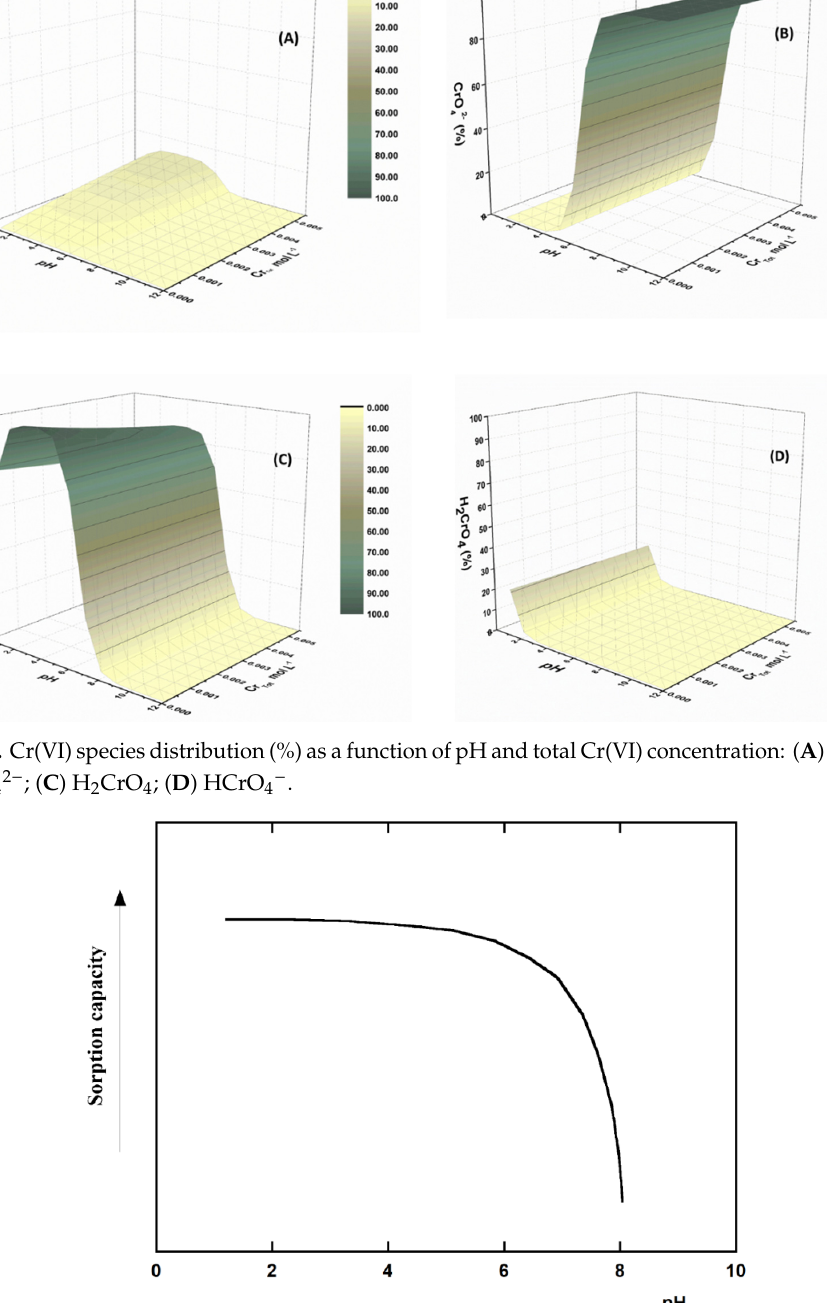
Figure 2. Typical decreasing trend of Cr(VI) sorption capacity vs. pH.